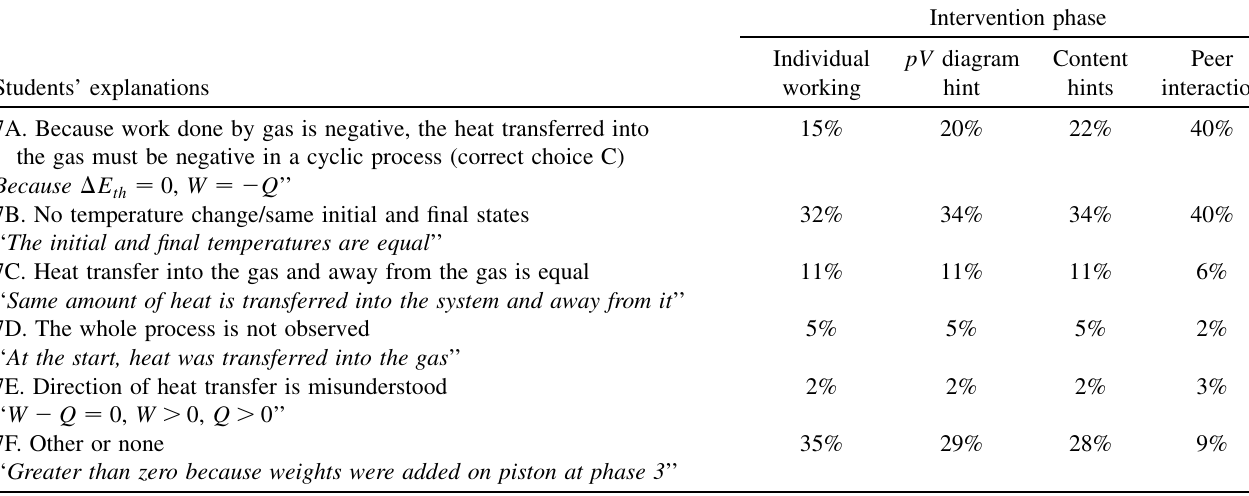
TABLE XIII. Students’ categorized explanations regarding the heat in a cyclic process. N ¼ 65 . A typical example from each category is presented after the category symbol in